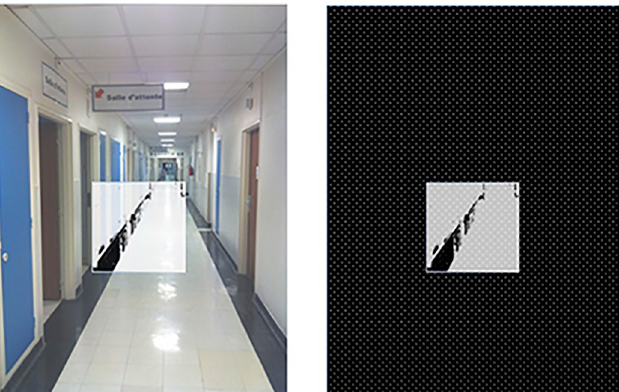
Fig 3. Square representation of the vision field accessed through the prosthesis. On the left you can see that it’s only a portion of the whole image, and on the right you can see how the “square image” might be perceived through the device (prior to being converted into electrical pulses that would result in phosphenes)